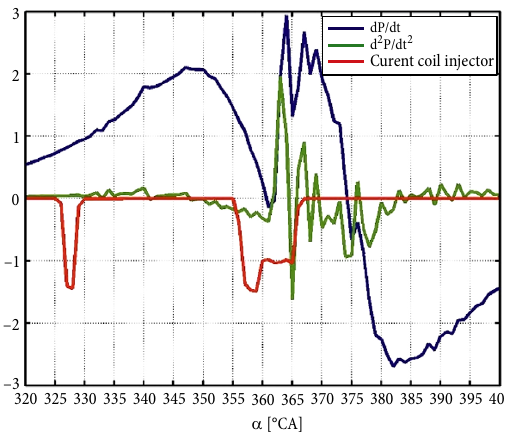
Fig. 13. A juxtaposition of the time series of the first and second derivative of the pressure in the combustion chamber with the time series of the injector controlling impulse;